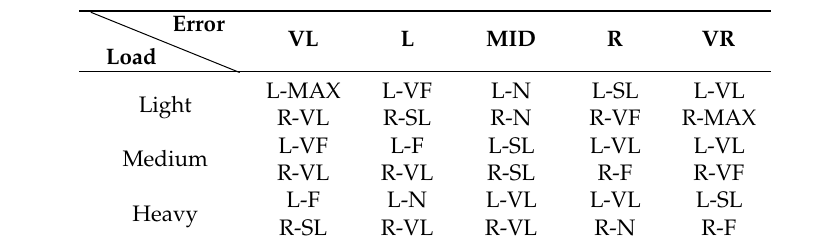
Figure 17. Structure of proposed fuzzy controller. Figure 16. Design of attaching mechanism for load cell ( a ) and loading actuator ( b ). Table 3. Table of rules in fuzzy sets.